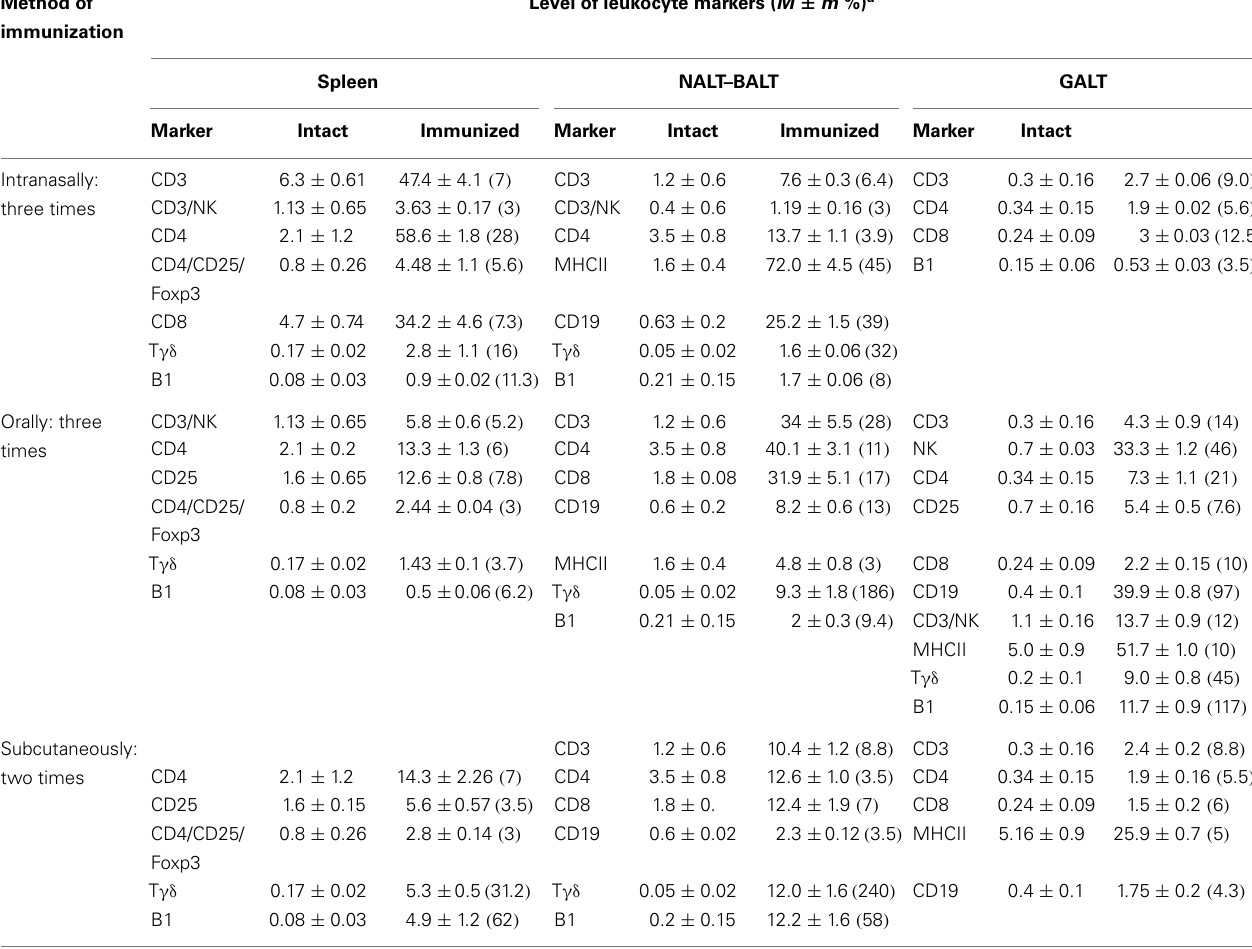
Table 1 |Activation of leukocytes by immunization method and tissue type. Method